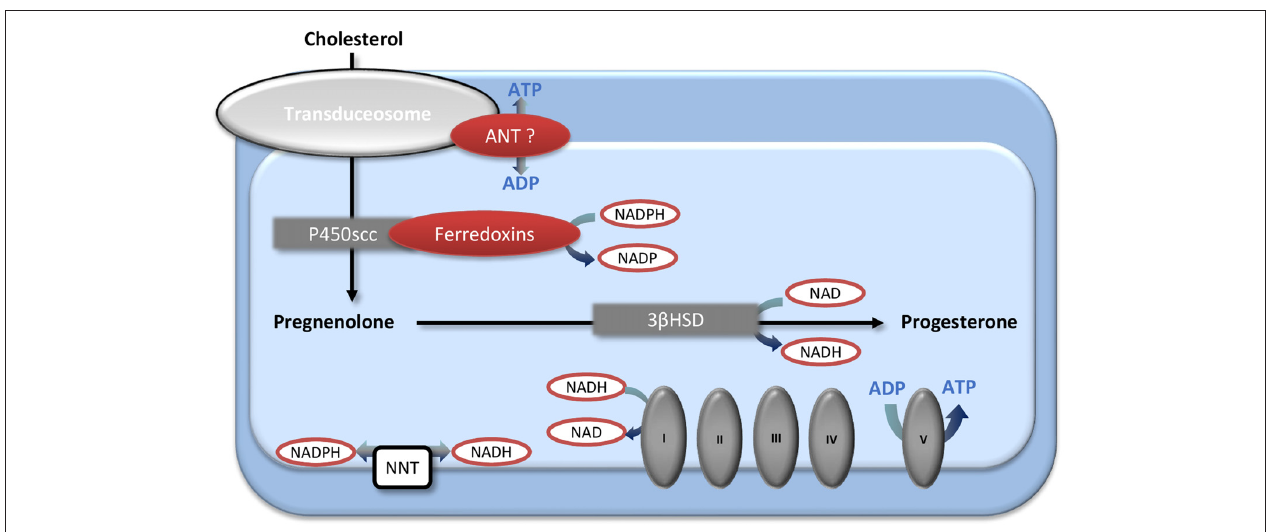
FIGURE 2 | The mitochondrial first steps of steroidogenesis and their interactions with energetic metabolism. Cholesterol enters into the mitochondria by the transduceosome and is converted into pregnenolone by the P450scc. The 3 β HSD, located both in mitochondria and endoplasmic reticulum, produces progesterone from pregnenolone. Mitochondrial energetic metabolism and steroidogenesis could interact by several ways. The ADP/ATP transporter adenine nucleotide transporter (ANT) may be a part of the transduceosome; the P450scc-associated ferredoxins are regulated by the NADPH/NADP ratio that is linked with the NADH/NAD ratio by the transhydrogenase NNT; NAD is a co-factor of 3 β HSD. 3 β HSD, 3 β -hydroxysteroid dehydrogenase; ANT, adenine nucleotide transporter; NNT, nicotinamide nucleotide transhydrogenase; P450scc, cholesterol side-chain cleavage enzyme cytochrome